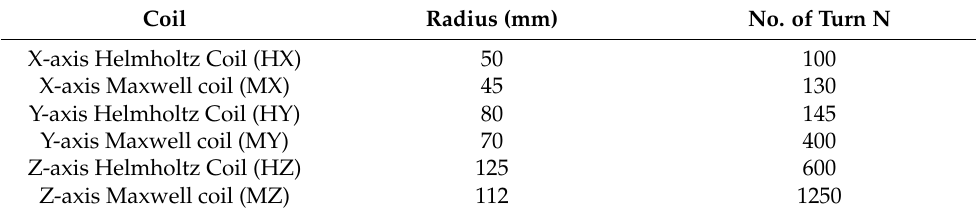
Table 1. Main parameters of the proposed EMA coils.